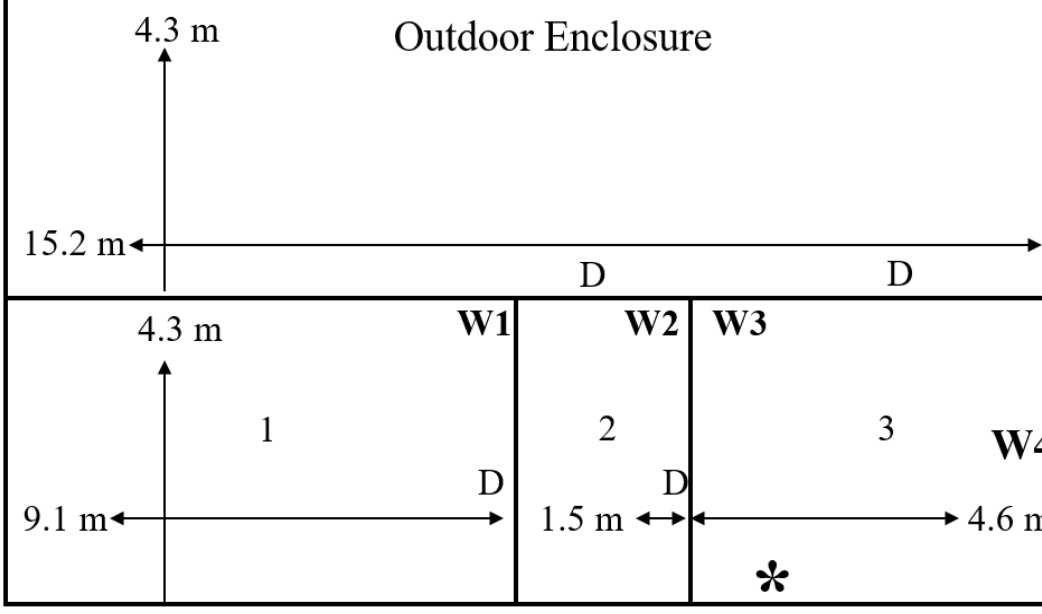
Note. The length and width of the enclosures are indicated. The apparatus was set up in the indoor enclosure 3, with the position marked with a star (called ‘experimental enclosure’ in the text). Doors between enclosures are marked with a D. Water